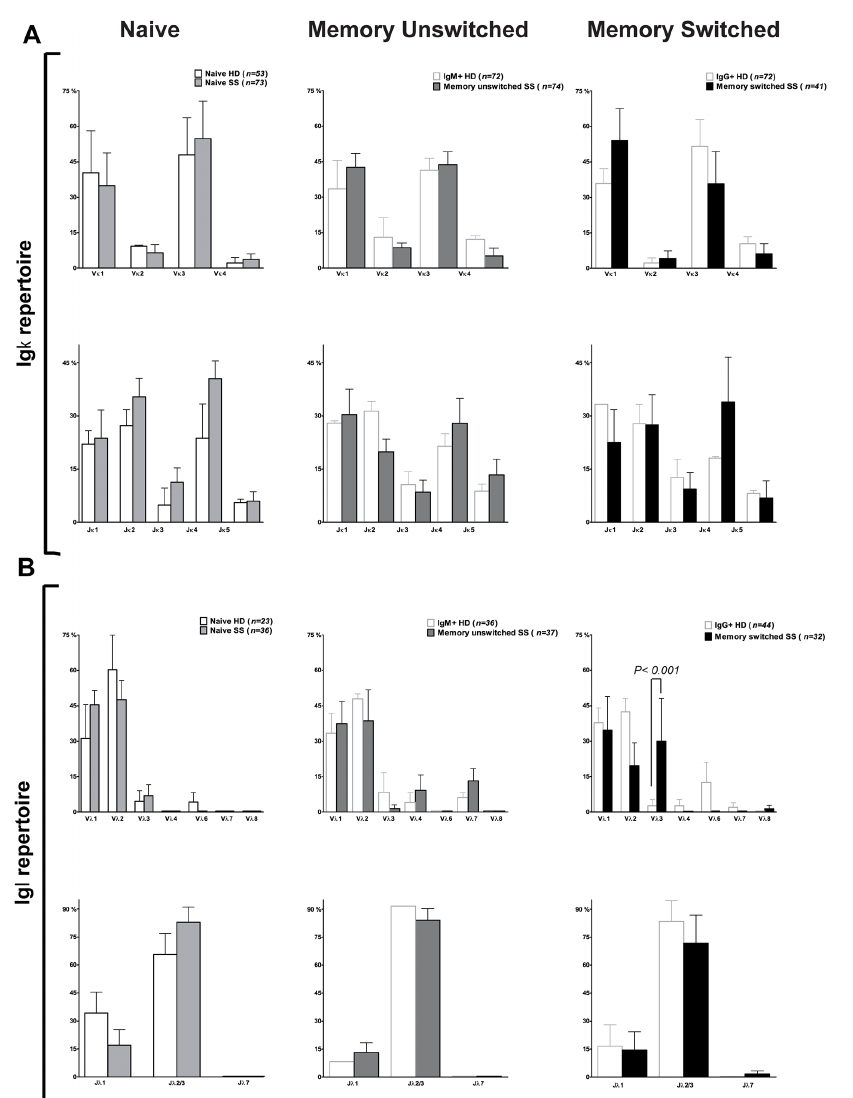
Fig. 3. Ig gene analysis of naı¨ve and memory B cells from SS patients and HD. Single naı¨ve and memory unswitched and switched B cell antibodies from SS patients and HD [ 19–21] were analyzed for Ig V k and J k ( A ) and Ig V l and J l ( B ) gene usage. The absolute number of sequences analyzed is reported over each graph. Error bars in bar graphs indicate standard error of mean (SEM) for individual patient or